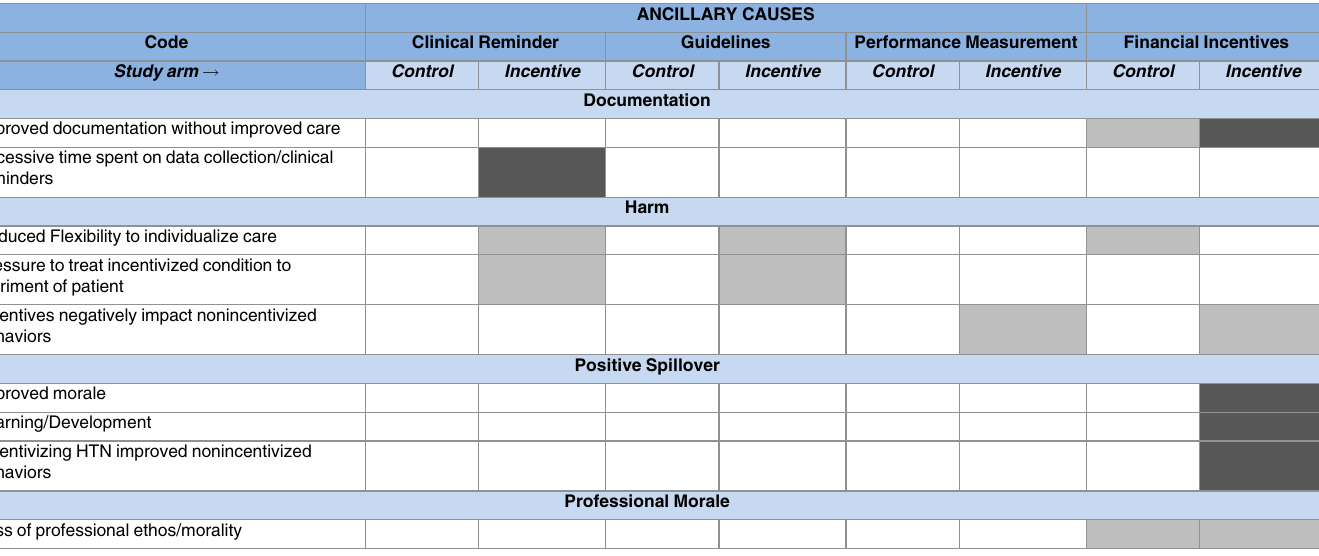
Table 3. Presenceand absence of study-related codes organized by theme and ancillary